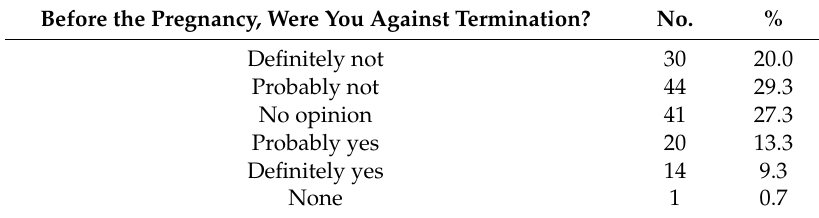
Table 2. Past views on termination among patients who terminated pregnancy for medical reasons. Before the Pregnancy, Were You Against Termination?